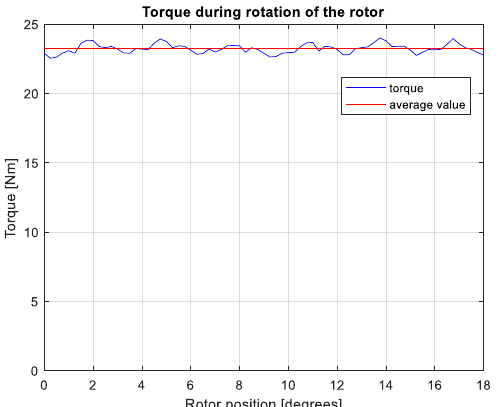
Figure 13. Torque calculations of a Fractional Slot Concentrated Winding—Permanent Magnet Brushless DC (FSCW PMBLDC) machine with 40 poles and 36 teeth ‐ coils considering saturation.